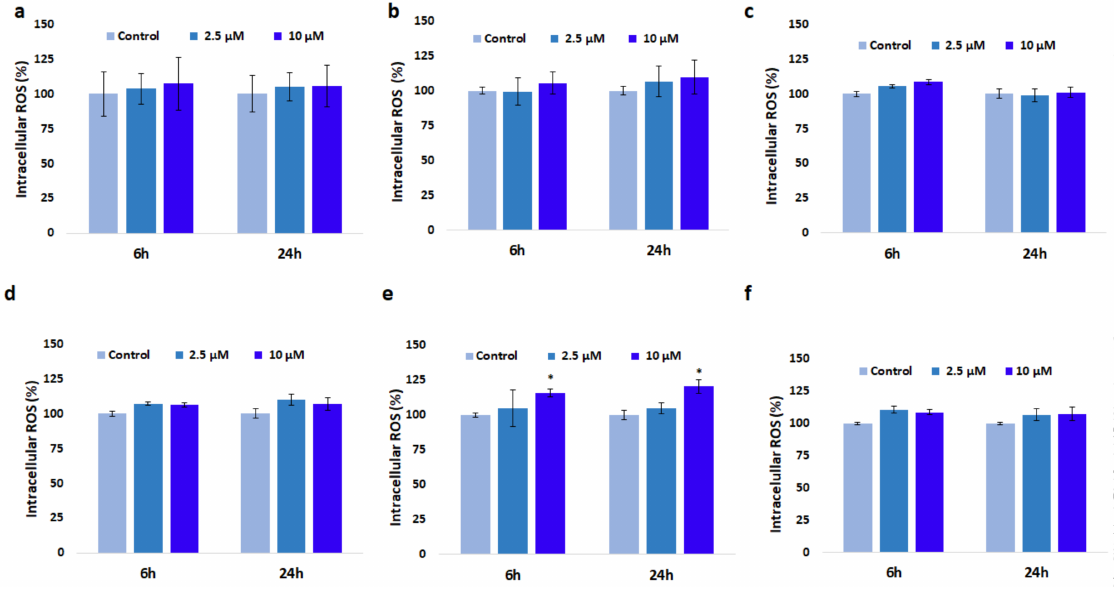
Figure 3. The intracellular reactive oxygen species (ROS) levels in SVEC4-10 cells in the presence of increased concentrations of ( a ) GdDOTP citric acid, 2.5 mg · mL − 1 CS; ( b ) GdDOTP acetic acid, 2.5 mg · mL − 1 CS; ( c ) GdDOTP citric acid, 1.5 mg · mL − 1 CS; ( d ) GdDOTP acetic acid, 1.5 mg · mL − 1